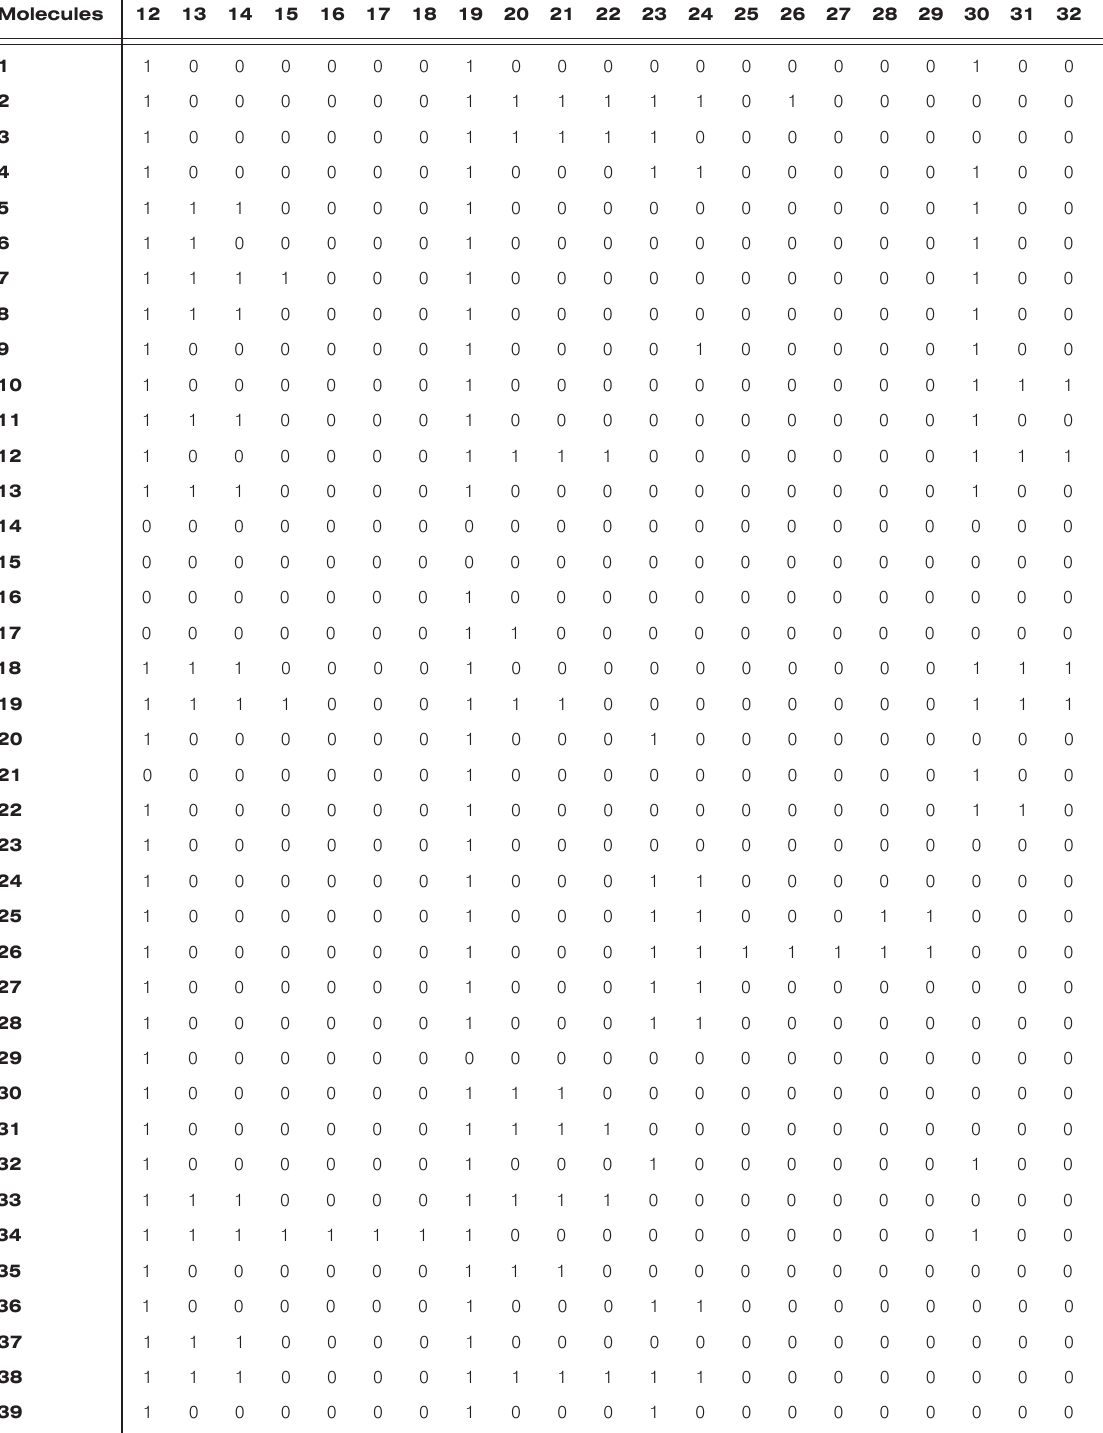
Table 2. Partial list of the binary vectors, cf. hypermolecule, for the 40 caffeine derivatives.